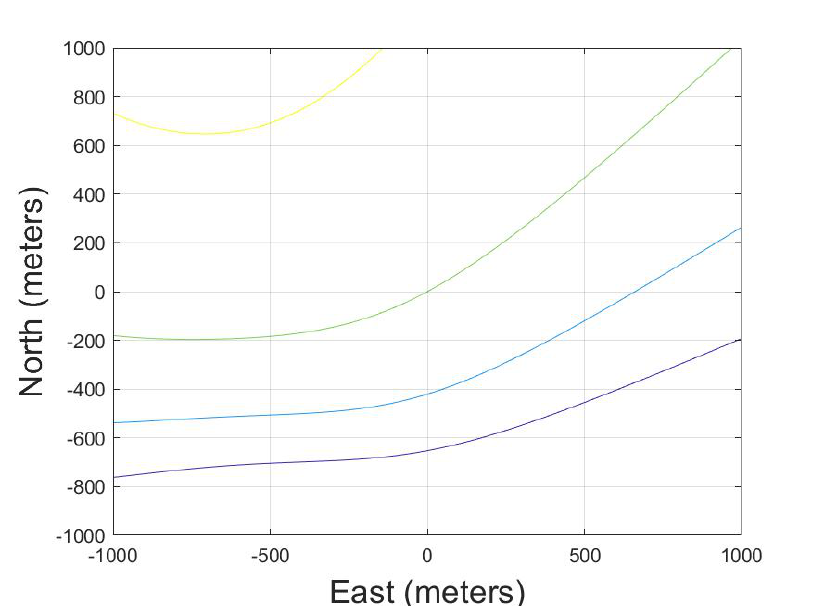
Figure 11. The range direction in the simulation configuration.